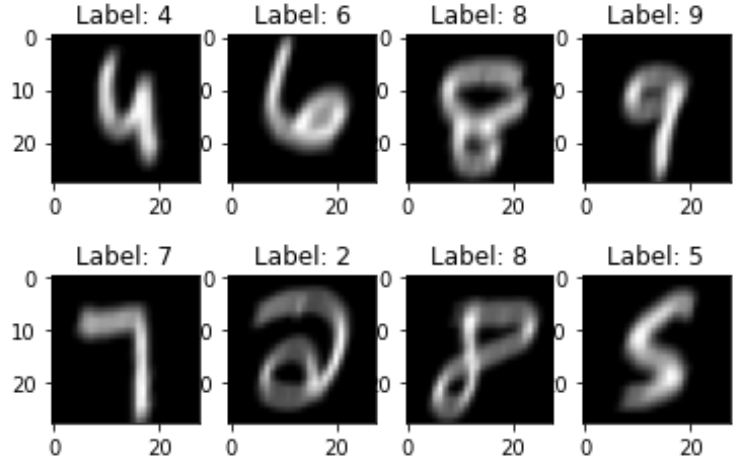
Figure 10. Image samples from MNIST dataset with motion-blur